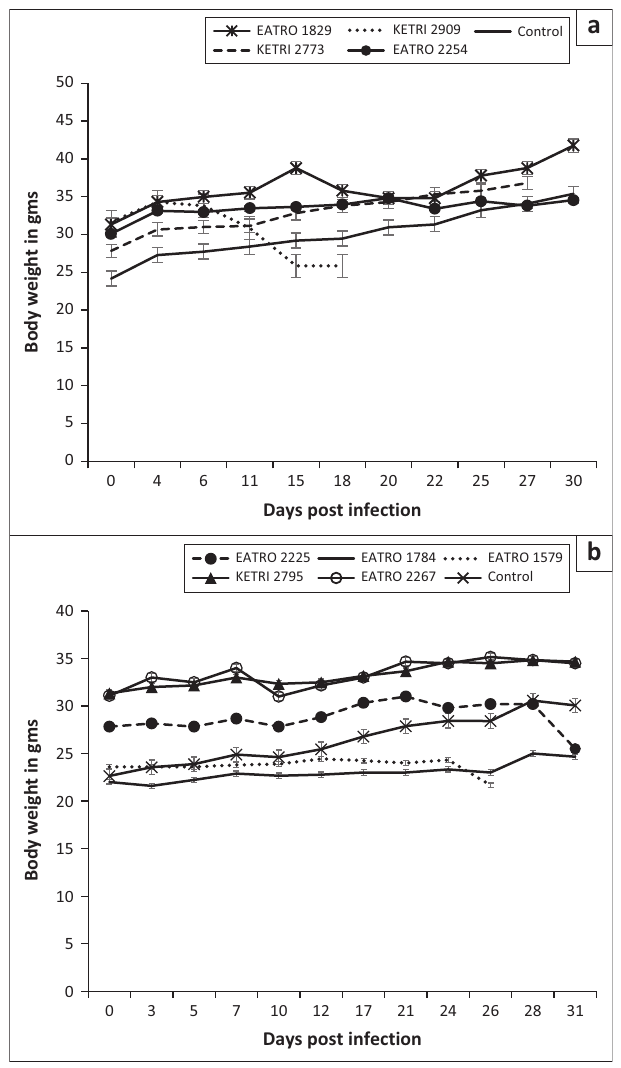
FIGURE 3: Bodyweight profiles of mice (a) (mean ± standard error of the mean; n = 4) infected with various isolates of Trypanosoma congolense and (b) (mean ± standard error of the mean; n = 5) infected with various isolates of Trypanosoma brucei